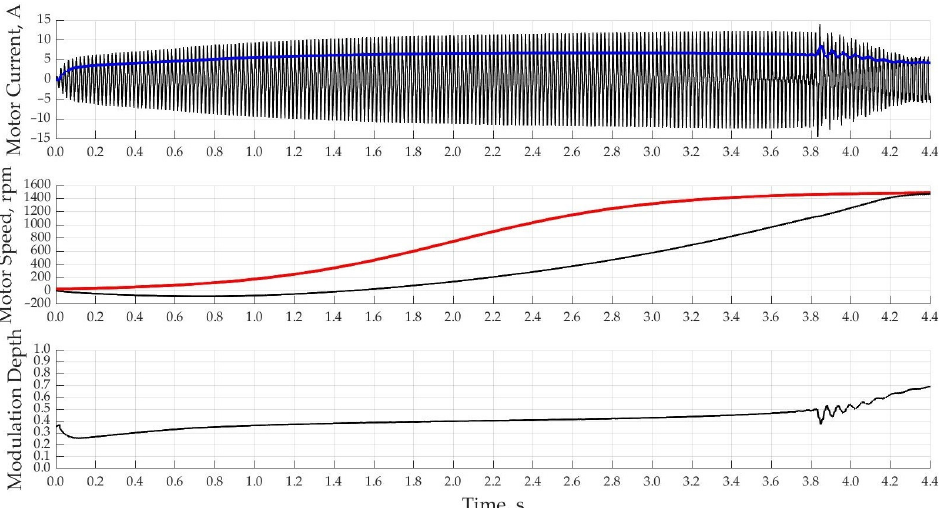
Figure 18. Starting current, motor speed and modulation depth for case of PI-controller with double- loop CS of IM current and speed with sigmoidal increase in speed by reference and loaded shaft.